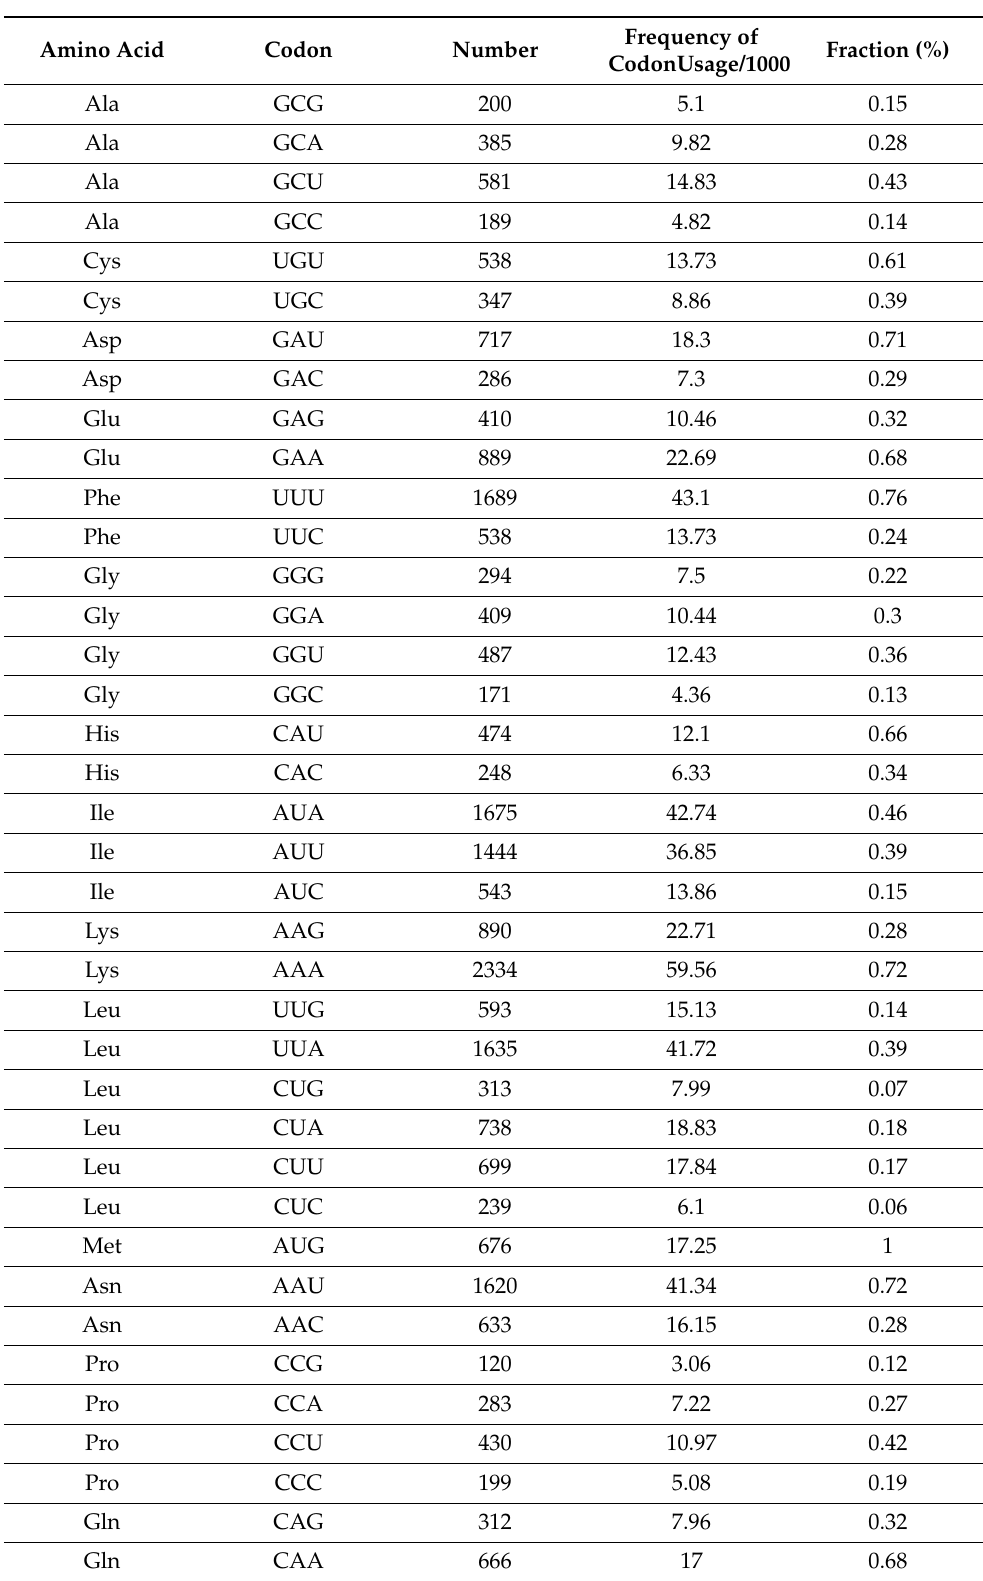
Table 4. Codon usage of PCGs in the mitogenome of O. lanpingensis